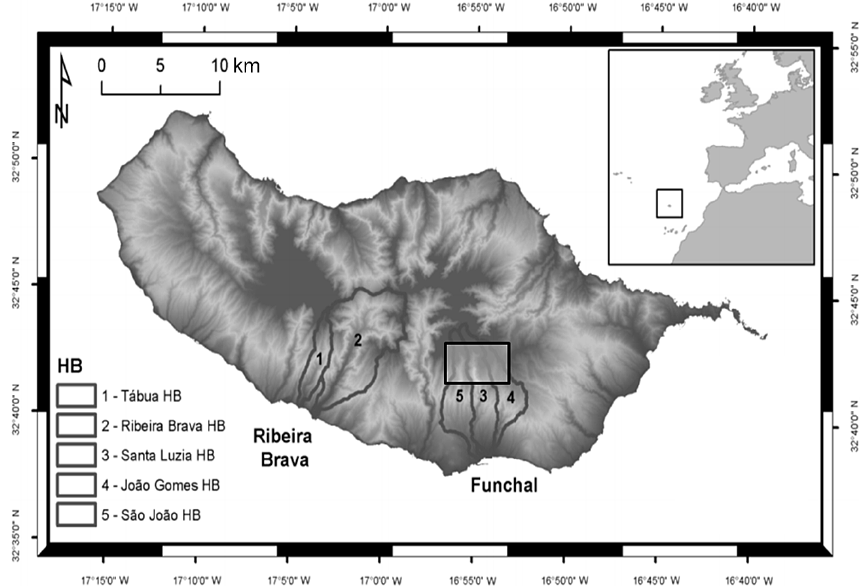
Figure 1. Location of Madeira Island, in the North Atlantic, with the most affected basins during the 2010 event superimposed on a DTM. Our study area is delimited by the rectangle located over Funchal basins. HB: hydrographic basin. Adapted from Lira et al.